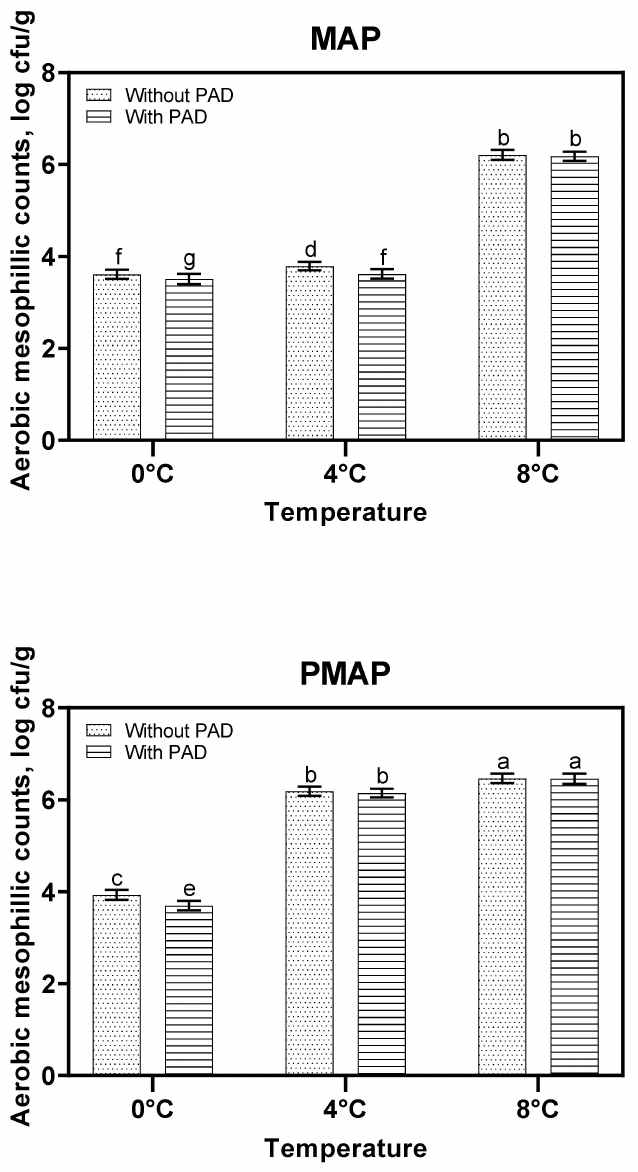
Figure 7. Effects of temperature (0 ◦ C, 4 ◦ C, and 8 ◦ C) and packaging with/without absorbent pads on bacterial growth of fillets on day 3. Different letters indicate a significant difference in aerobic mesophillic count ( p < 0.001). MAP = active-MA and PMAP =